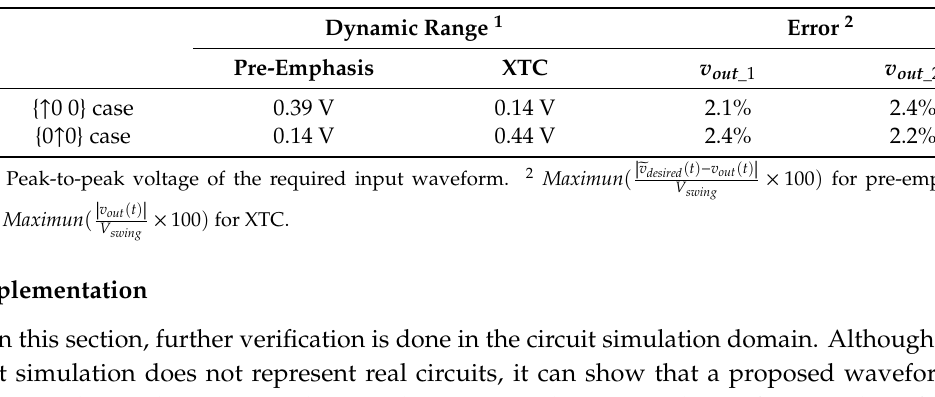
Table 2. Summary of multi-line design results.